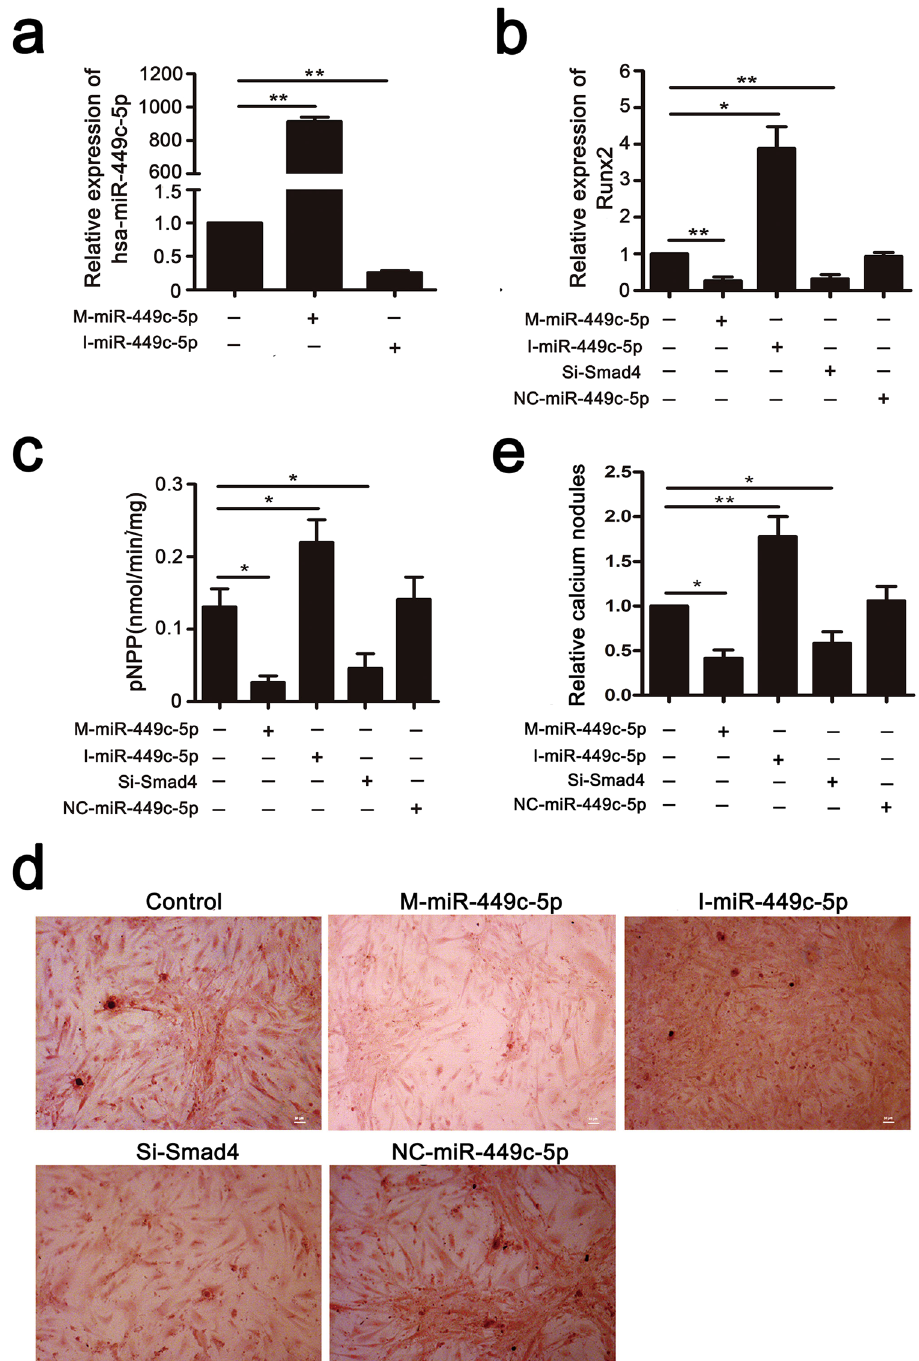
Figure 3. Overexpression of miR-449c-5p inhibits VICs osteogenic differentiation while downexpression of miR-449c-5p promotes the process. ( a ) qRT-PCR analysis of miR-449c-5p expression in VICs transfected with miR-449c-5p mimic or inhibitor at day 2. ( b ) qRT-PCR analysis of Runx2 expression at day 7 after osteogenic differentiation. ( c ) ALP activity at day 14 after osteogenic differentiation. ( d ) Alizarin red staining at day 14 after osteogenic differentiation. ( e ) Quantitative analysis of alizarin red staining. n = 3 in each group. Data are presented as the mean ± SD. * P < 0.05, ** P <